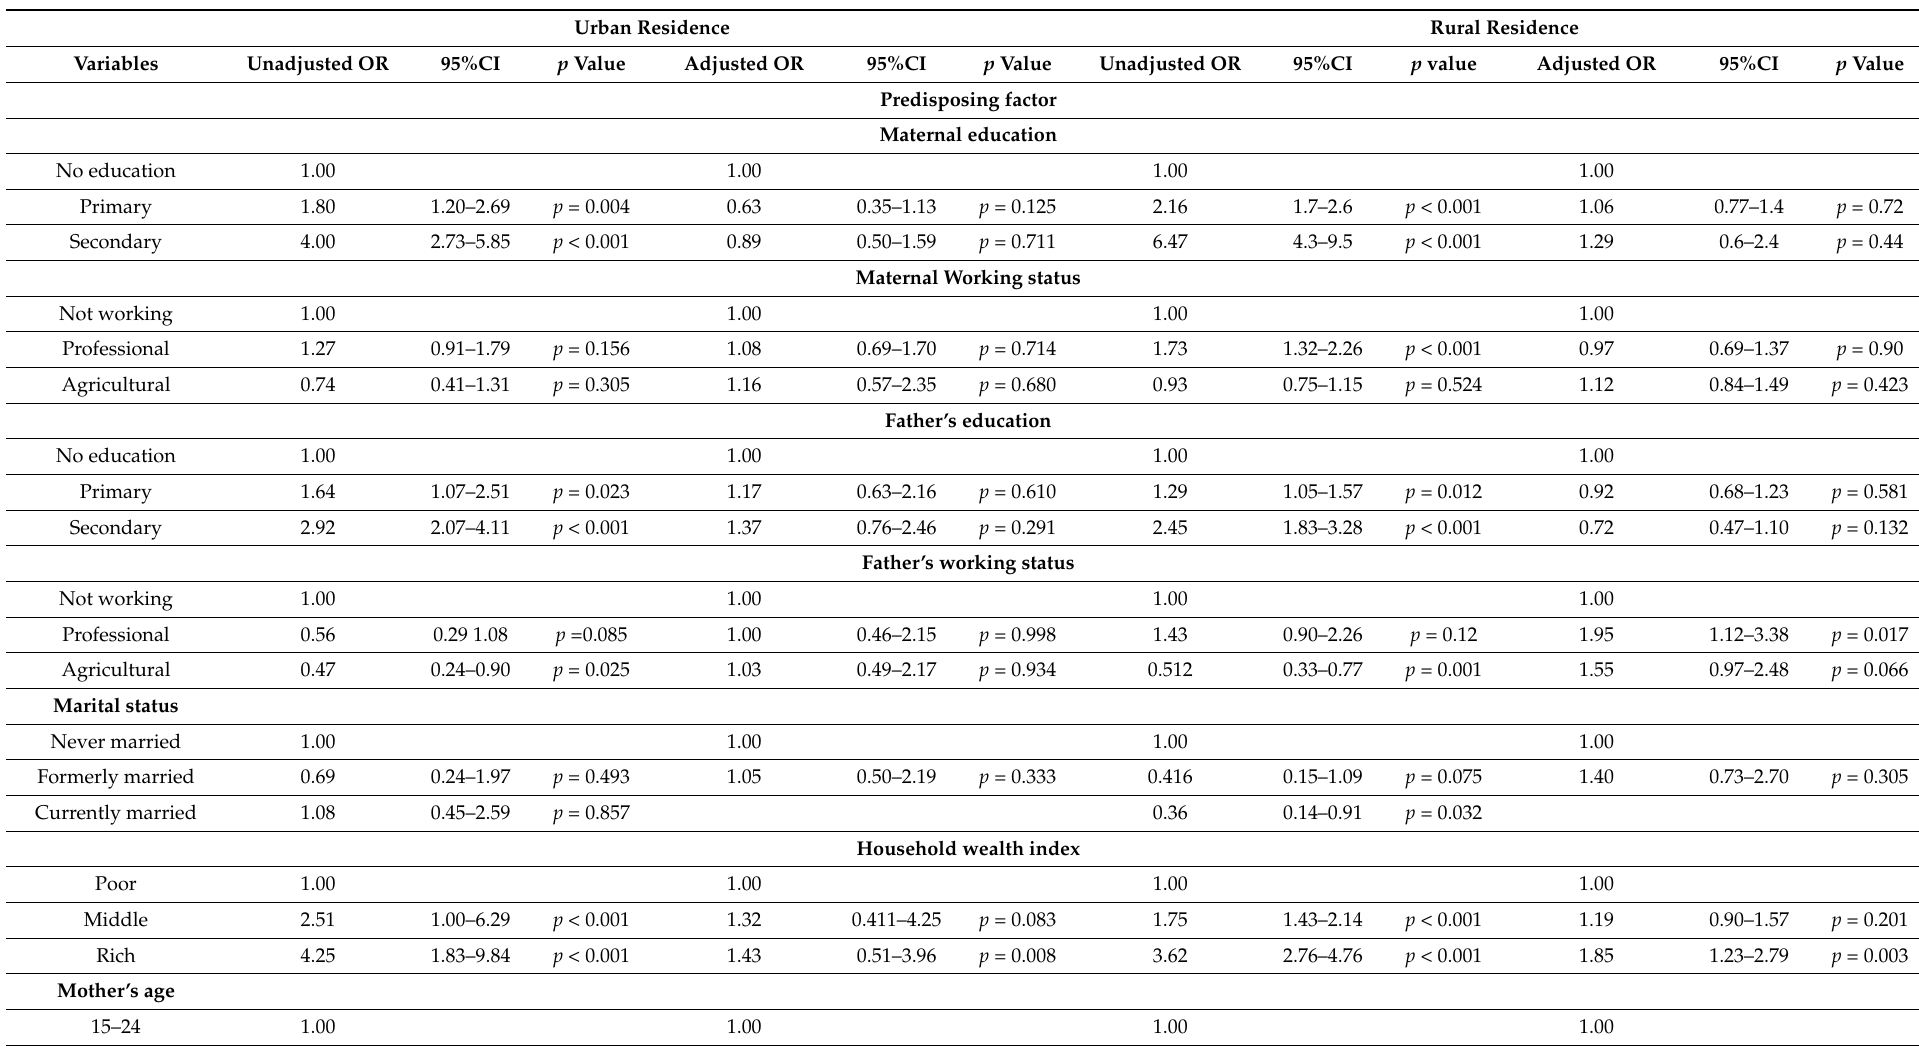
Table 3. Determinants of PNC use in urban and rural Ethiopia (EDHS) 2000–2016 (n =